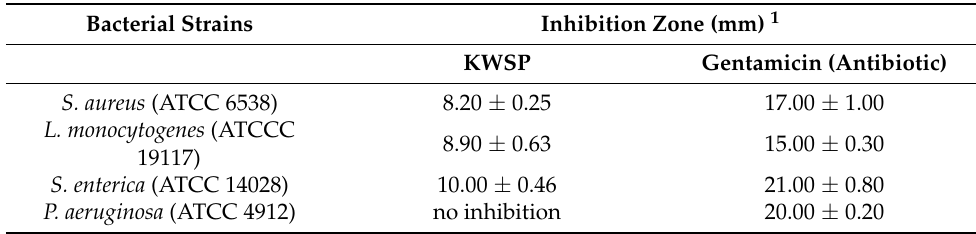
Table 4. Antibacterial activities of KWSP.